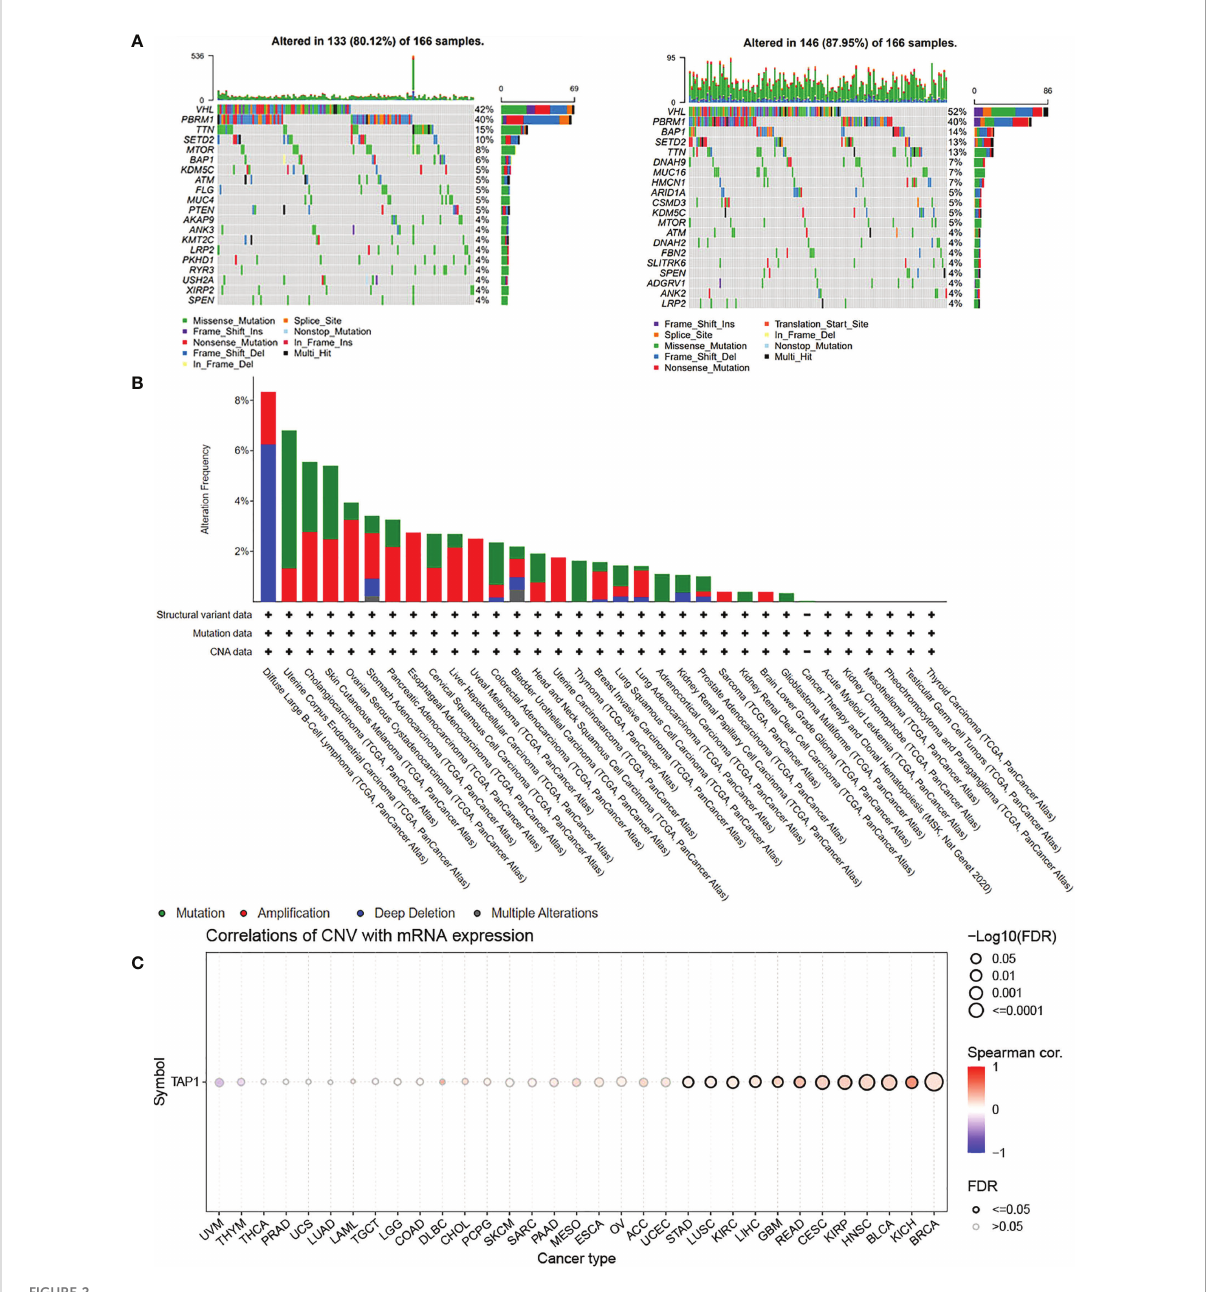
FIGURE 2 Genomic Alteration Analysis of TAP1. (A) Landscape of genomic alteration in low-(Left) and high-(Right) expression groups of TAP1. (B) Alteration Frequency of TAP1 in para-cancer indicates TAP1 is conservative in Kidney renal clear cell carcinoma (KIRC). (C) TAP1 mRNA expression is highly related to copy number variations (CNV) in KIRC.(p <